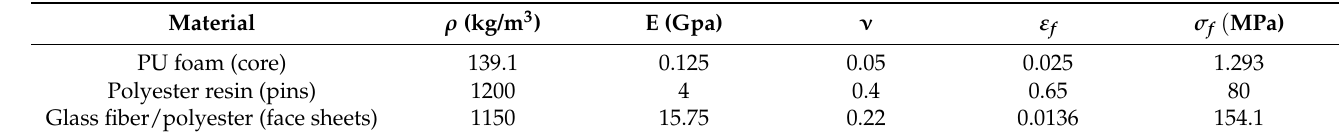
Table 1. Mechanical properties of material contents of PFCS panels [9].